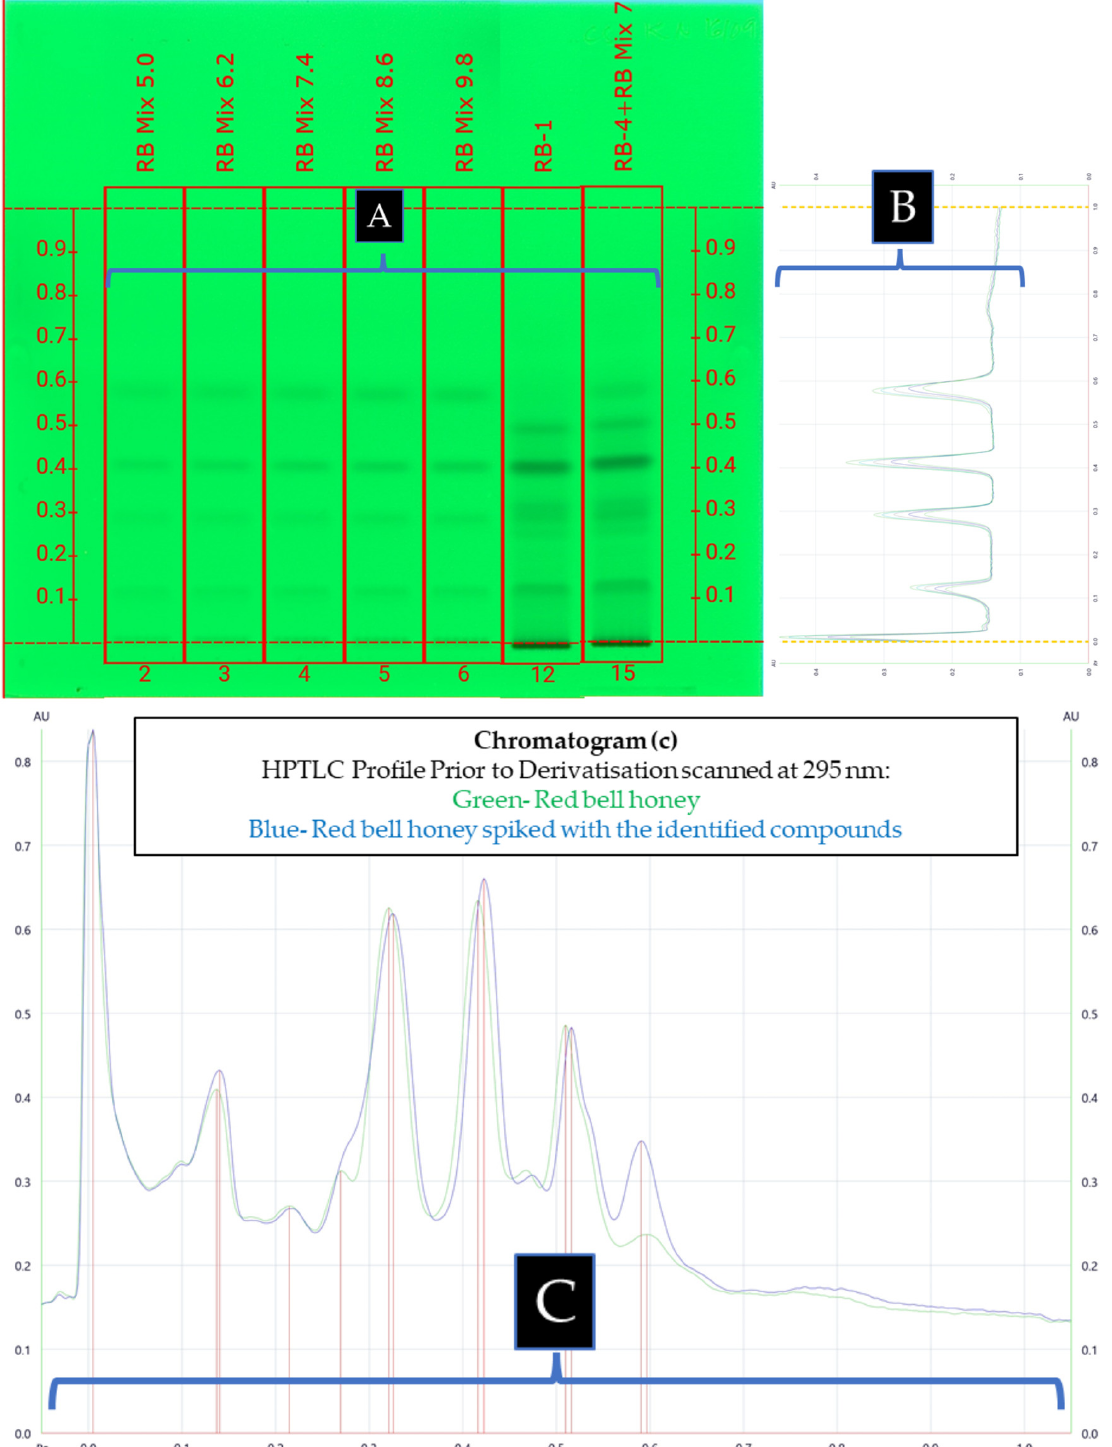
Figure 8. ( A ) HPTLC Images of the compound mixture of identified compounds in Calothamnus spp. (Red Bell) honey using various application volumes (Tracks 2–6) as compared to Red Bell honey (Track 12), and Red Bell honey spiked with the mixture of identified compounds (Track 15); ( B ) peak profile of compounds identified in Calothamnus spp. (Red Bell) honey; ( C ) peak profile of Red Bell honey (green), and Red Bell honey spiked with the identified compound mixture (blue) scanned at 295 nm using